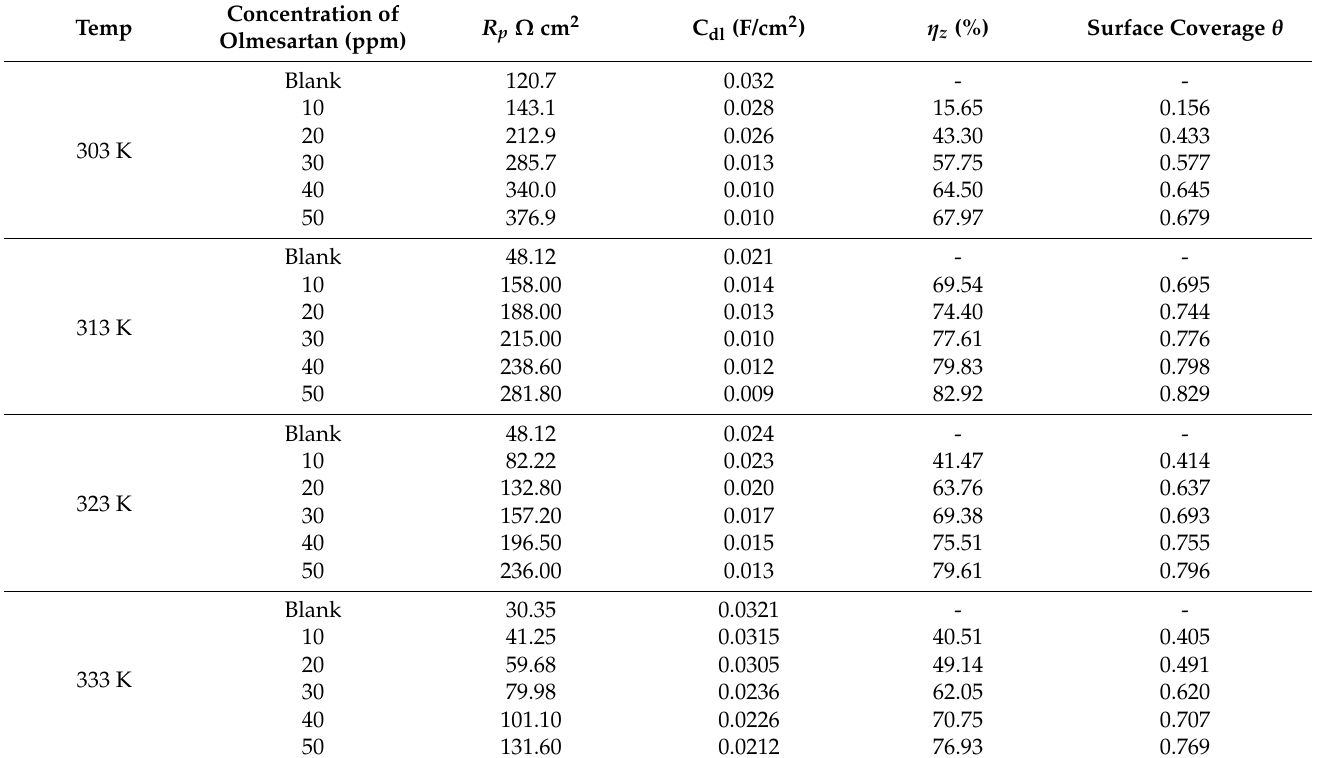
Table 4. The corrosion parameters for soft-cast steel in 1 mol dm − 3 HCl by EIS measurement. Concentration Temp